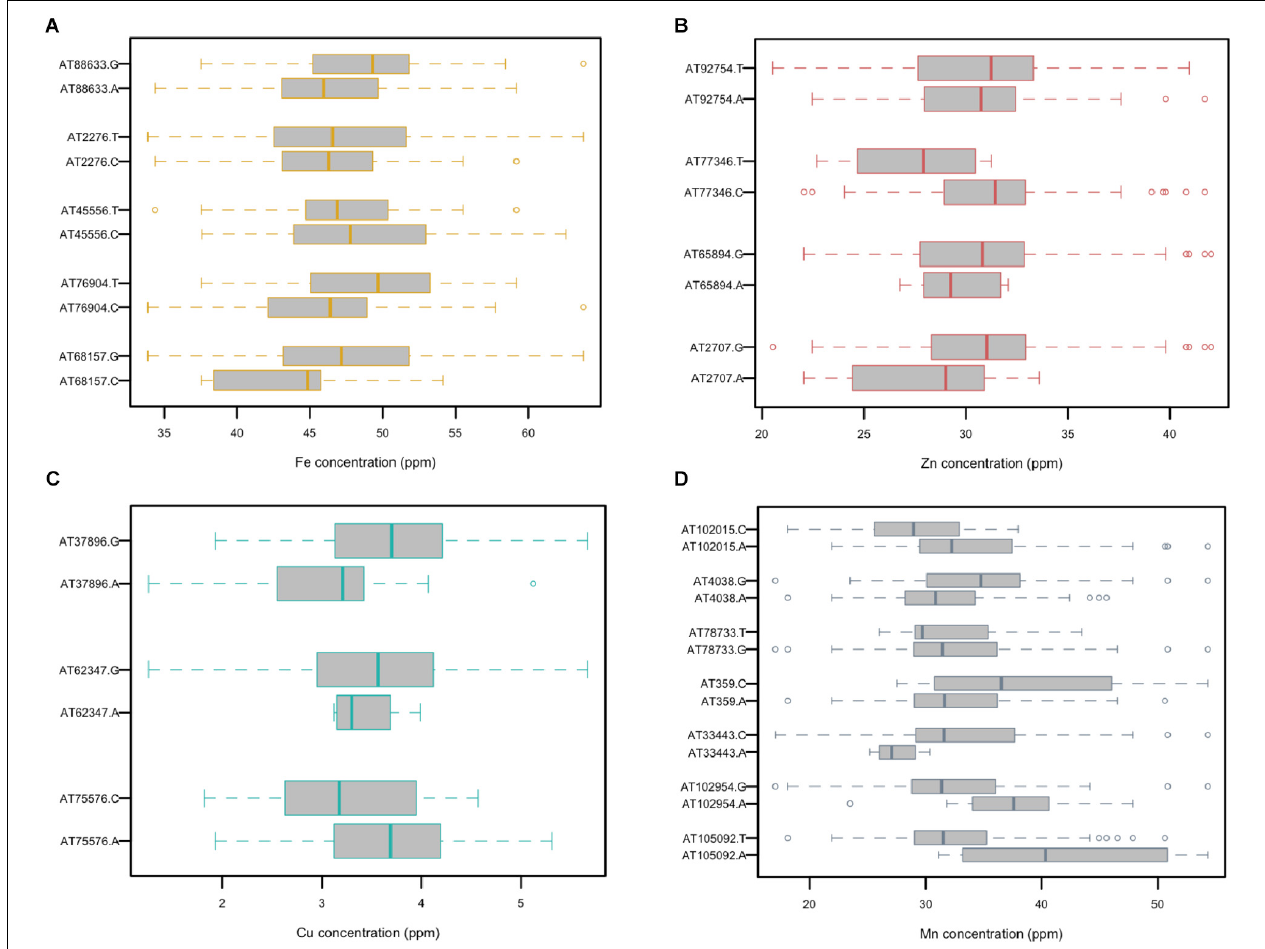
FIGURE 6 | Comparison of the allelic effects for the SNP markers associated with grain (A) Fe, (B) Zn, (C) Cu, and (D) Mn